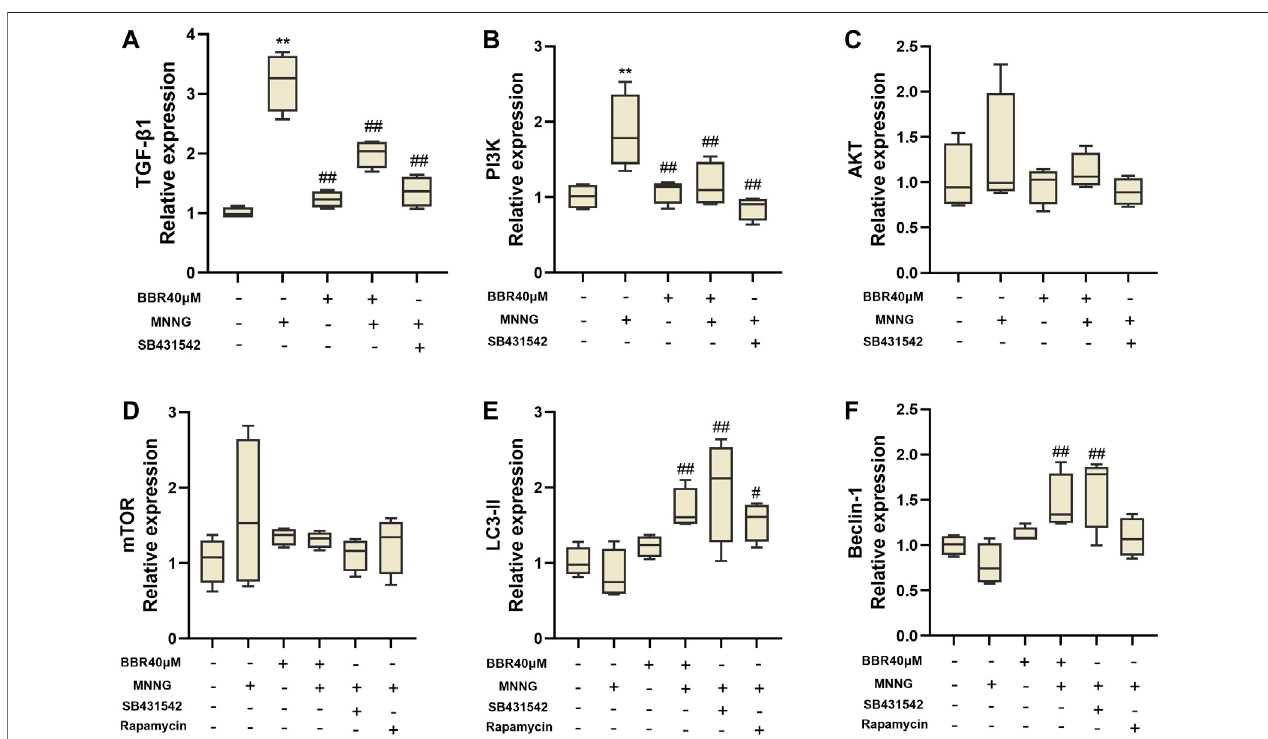
FIGURE 6 | Histogram of TGF- β 1 (A) , PI3K (B) , Akt (C) , mTOR (D) , LC3-II (E) and Beclin-1 (F) mRNA expression in MNNG co-cultured GES-1 cells by RT-PCR. Use SB-431542 and rapamycin to inhibit TGF- β 1 and mTOR respectively. Data were shown as mean ± SD ( N (cid:1) 4). ** < 0.01 vs. control group; * < 0.05 vs. control group. ## < 0.01 vs. MNNG group; # < 0.05 vs. MNNG